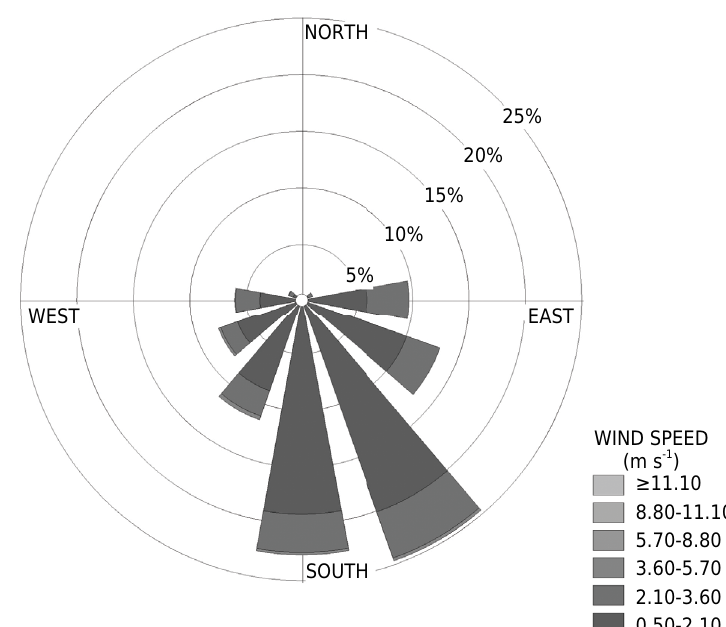
Figure 2. Regional average annual wind velocity and direction for the study